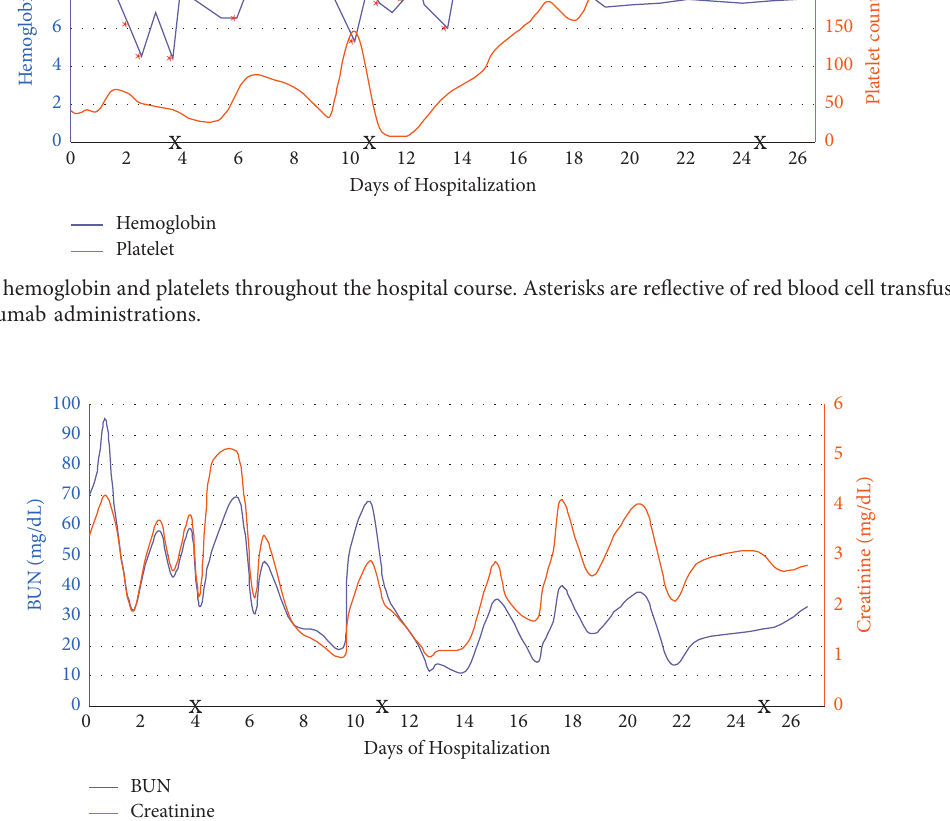
Figure 3: Trend of BUN and creatinine throughout the hospital course. X reflects eculizumab administration. Near daily sessions of hemodialysis occurred, with CRRT initiated days 7–17.